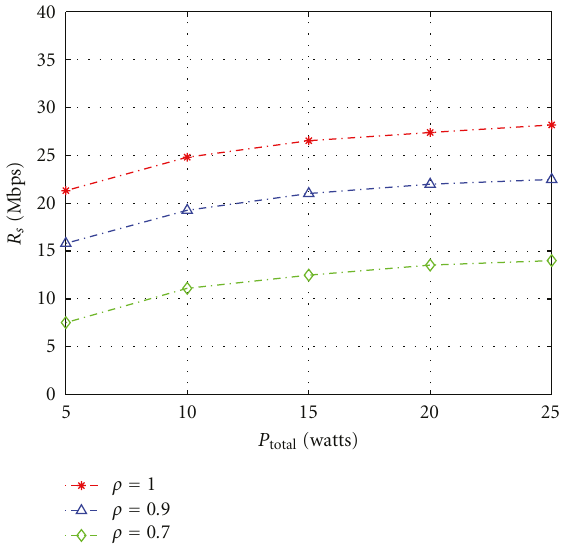
Figure 1: Average total CRU bit rate, R s , versus total CRU transmit power, P total , with I total = 0 . 02W, P m = 5W, and λ = [1 1 1